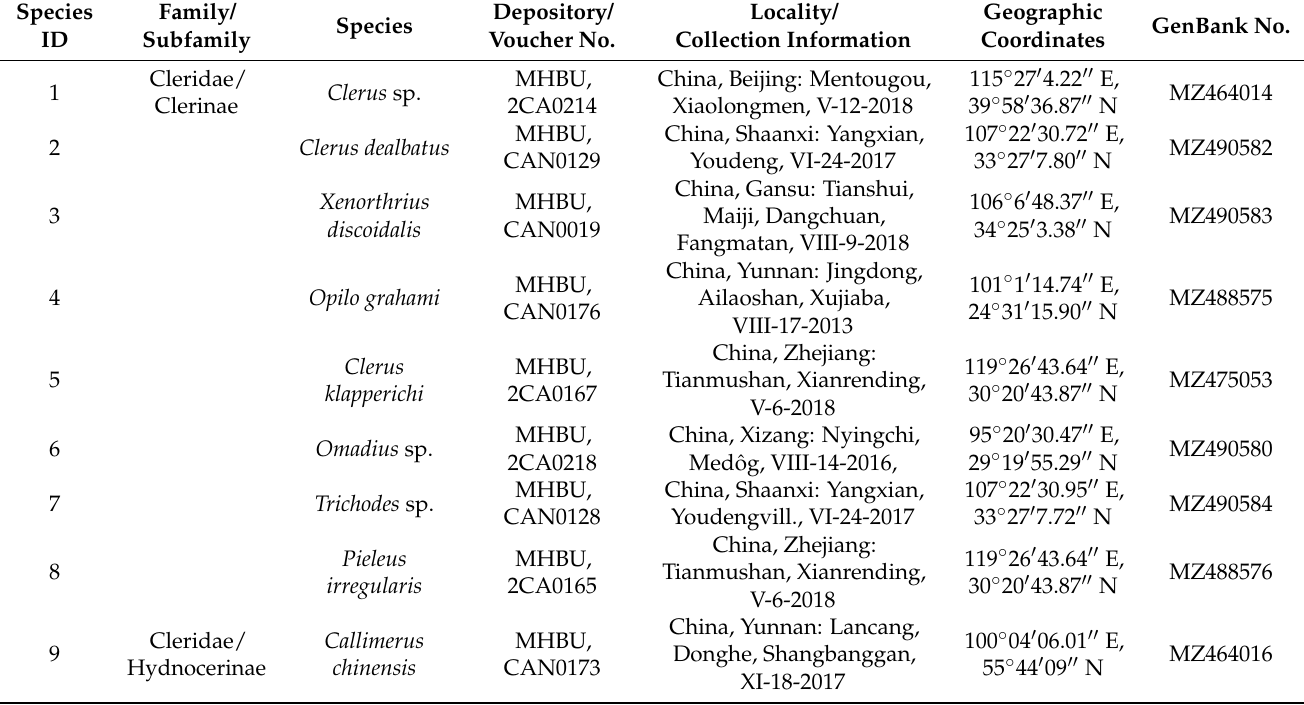
Table 1. Taxonomic information and GenBank accession numbers of mitochondrial genomes used in the